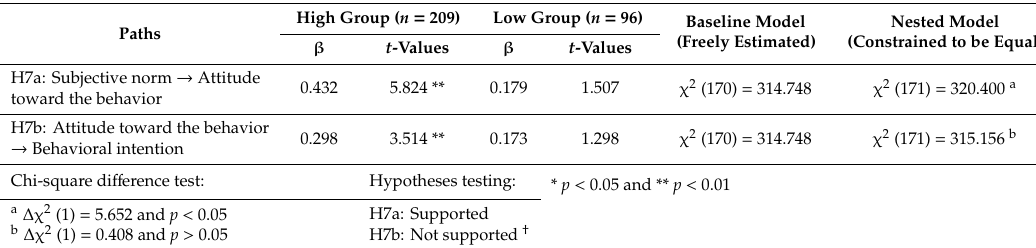
Table 3. Results of the structural invariance model—intrinsic variety